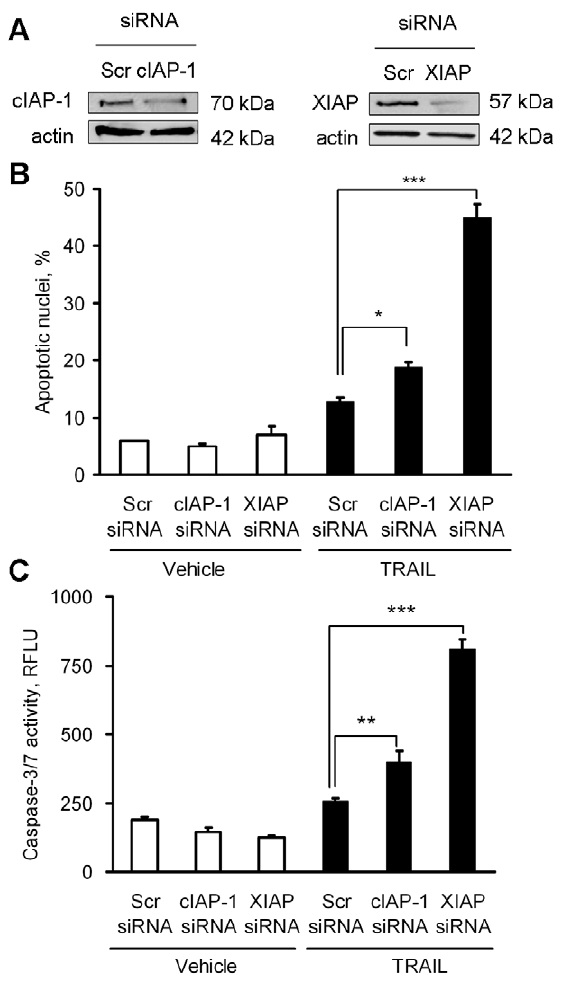
Figure 5. Knockdown of XIAP sensitizes human cholangiocar- cinoma cells to TRAIL cytotoxicity. KMCH cells were transfected with scrambled siRNA or specific siRNA for cIAP-1 or XIAP . A , Whole cell lysates were prepared for immunoblotting from KMCH cells 48 hours after siRNA transfection. B , Forty-eight hours after transfection as in panel A , cells were treated with human recombinant TRAIL (5 ng/mL) or medium for 5 hours. Cells were then stained with DAPI and cells with apoptotic nuclear morphology were counted and expressed as a percentage of total nuclei. C, In parallel, cells were transfected and treated with TRAIL as in panel B , and after 5 hours caspase-3/7 activity was measured. Mean 6 SEM, *p , 0.05; **p , 0.01; ***p , 0.001.